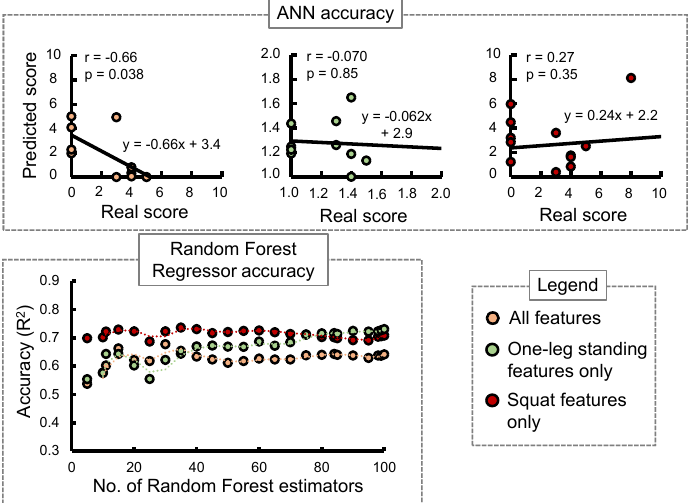
Figure 9. Comparing the accuracy of the ANN and Random Forest regressor in predicting the STBLS test GLFS-25